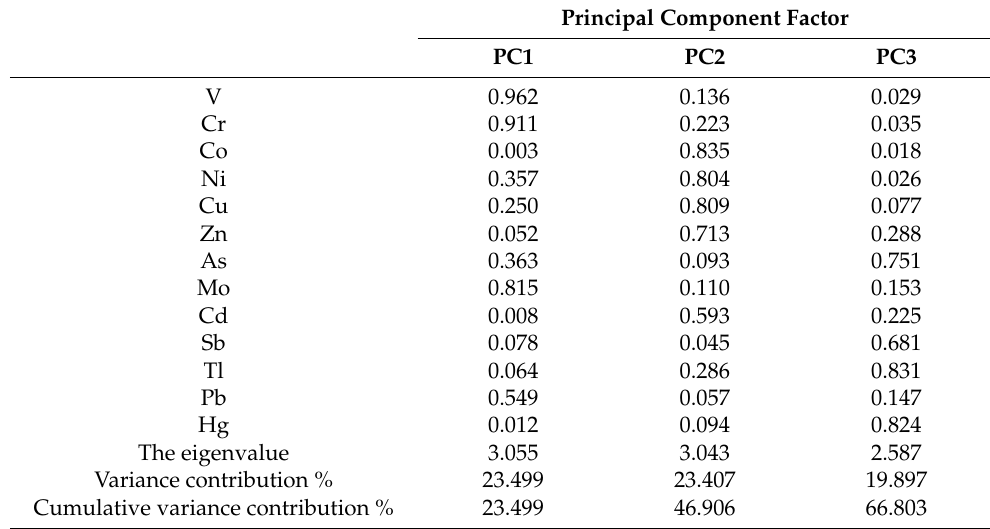
Table 5. Varimax rotated matrix of the principal component factors on the PTE contents in the